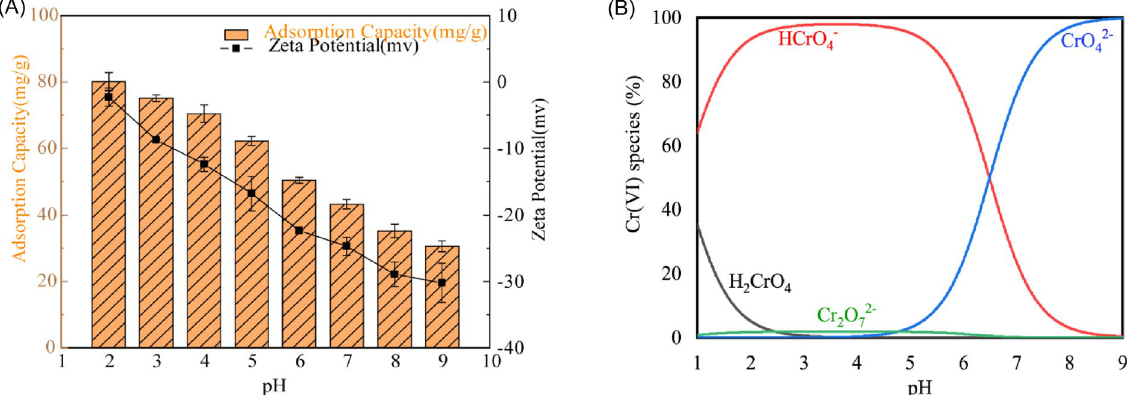
Fig. 4 Effect of pH on the removal of the Cr (VI) and the corresponding zeta potential of EPS ( A ), species of H 2 CrO 4 , HCrO 4 − , Cr 2 O7 2 − and CrO 42 − at different pH, C 0 50.0 mg/L, T 298 K ( B = =